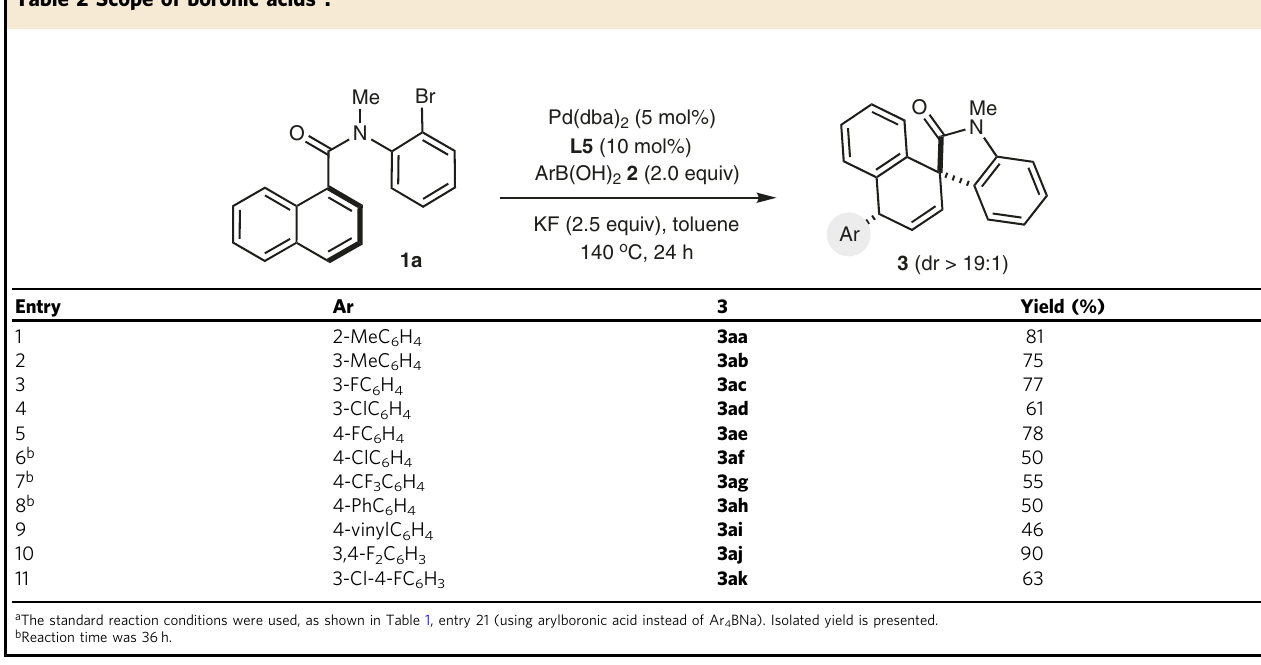
Table 2 Scope of boronic acids a .